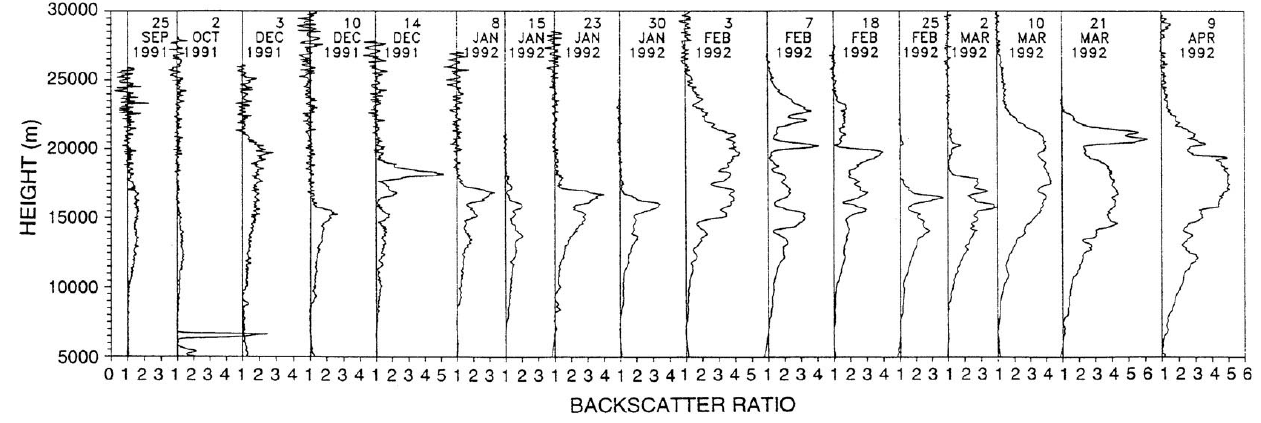
Fig. 6. Backscatter ratio profi les measured with lidar at Thule (Di Girolamo et al. ,